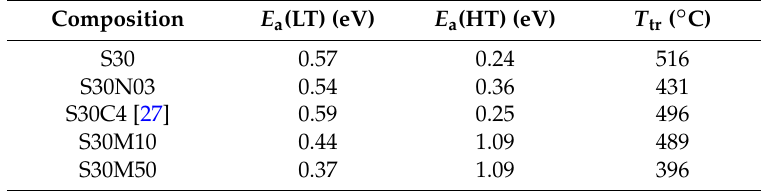
Table 3. Activation energies at LT and HT, and the temperature of turning-point of doped S30.